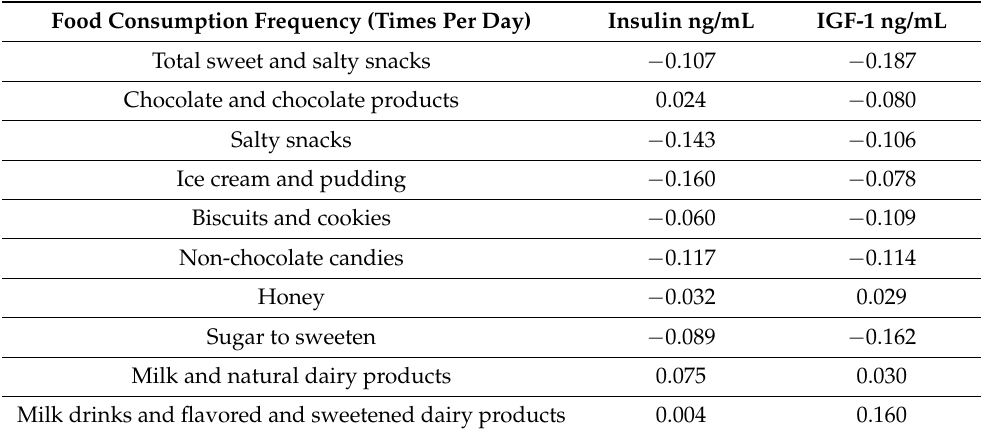
Table 5. Spearman’s correlation of the food consumption frequency and maternal insulin and IGF-1 concentrations ( n = 157) .